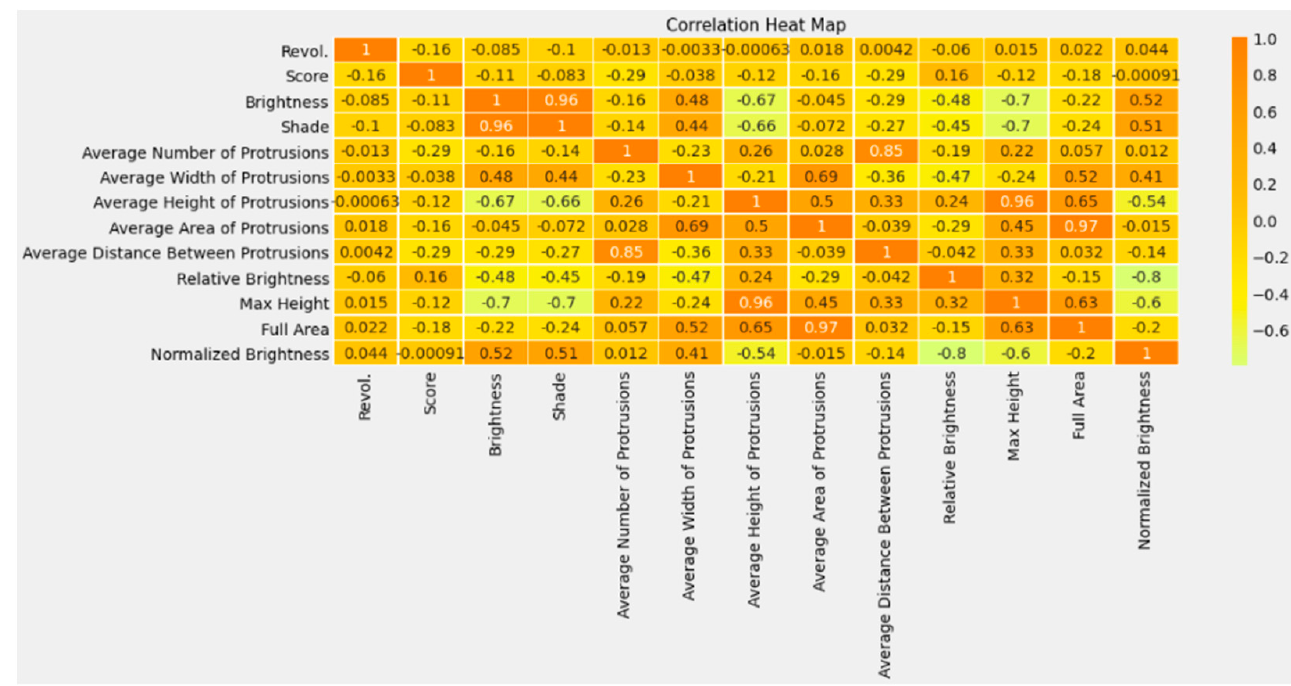
Figure 10. Effect of average height of protrusions on the target class.